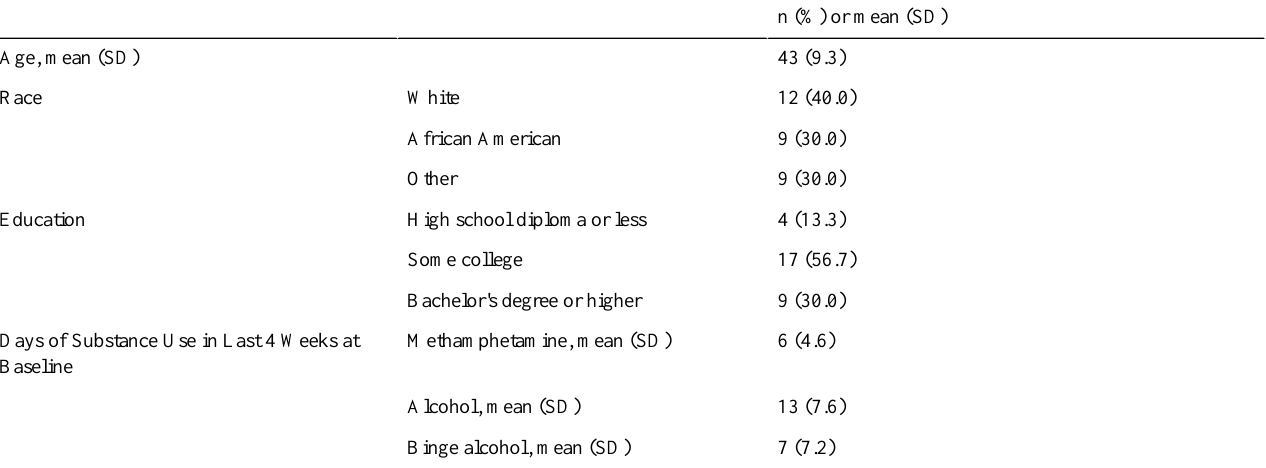
Table 1. Demographic and substance use characteristics of study participants